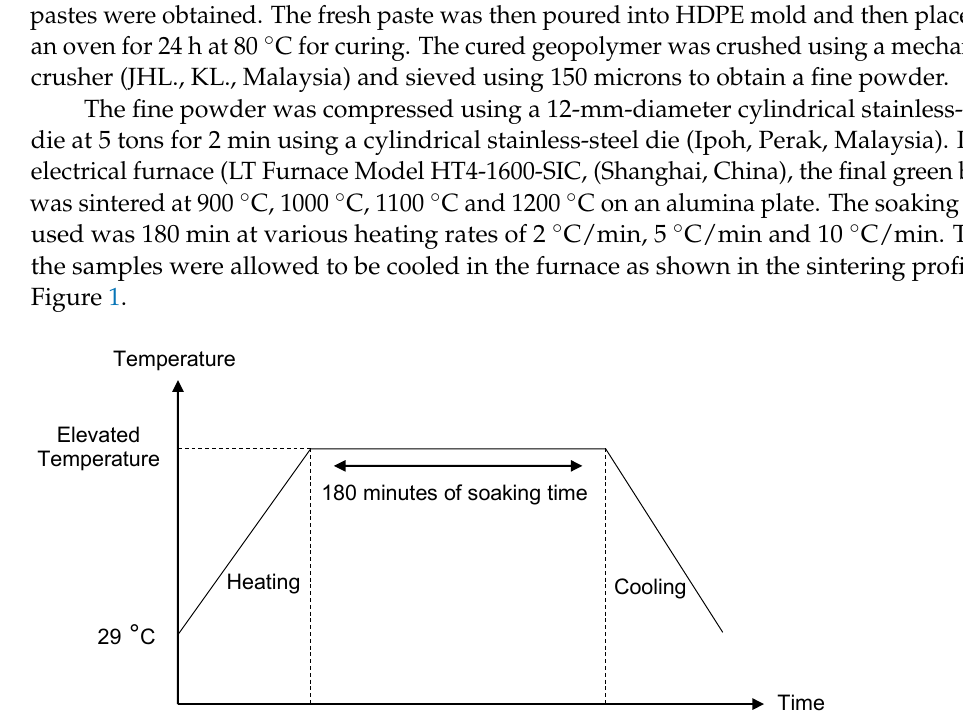
Figure 1. Sintering profile for fabrication of geopolymer-based nepheline ceramic.